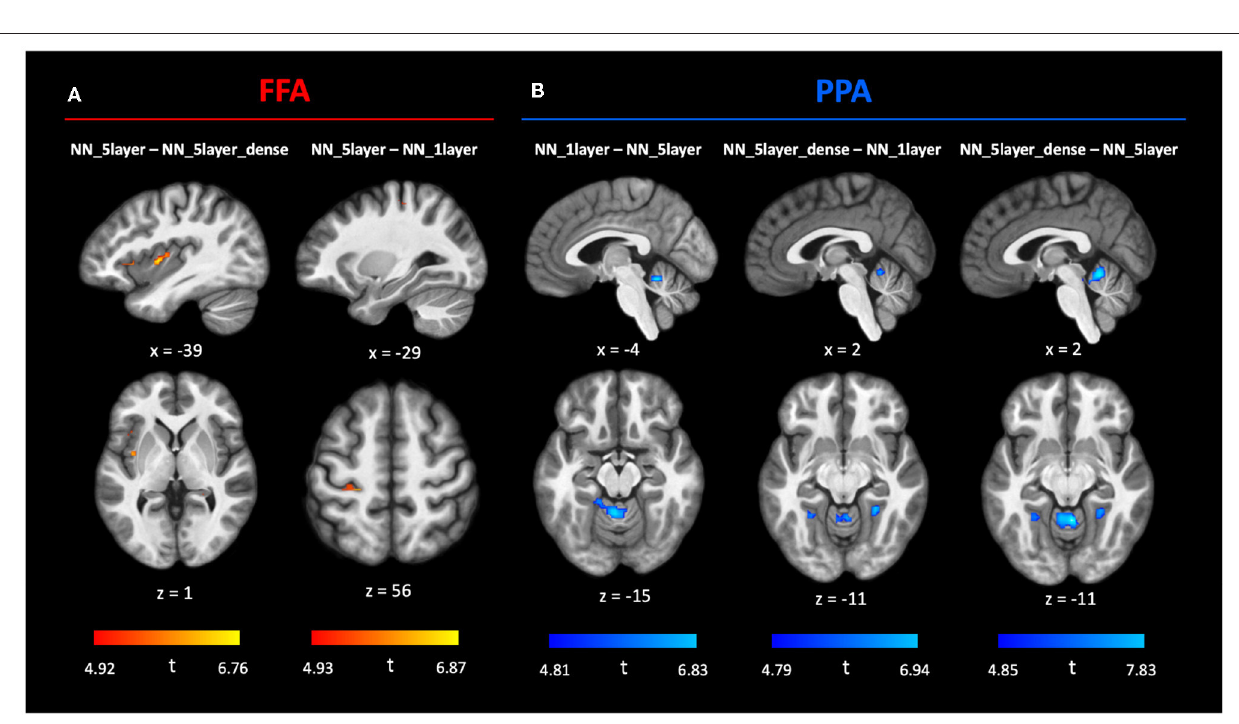
FIGURE 4 | Comparison between MVPD neural network (NN) models. Statistical t-maps computed across subjects from the pairwise difference between the variance explained predicted by three neural network models ( NN_1layer, NN_5layer, NN_5layer_dense ) with FFA (A) and PPA (B) as predictor ROIs, respectively. The SnPM p -values were Bonferroni corrected for all 6 comparisons. We showed interesting brain regions that were better predicted by one NN model than the other NN model at p < 0.05 FWE after Bonferroni correction. The full NN model comparison results can be found in Supplementary Table 1 (FFA) and Supplementary Table 2